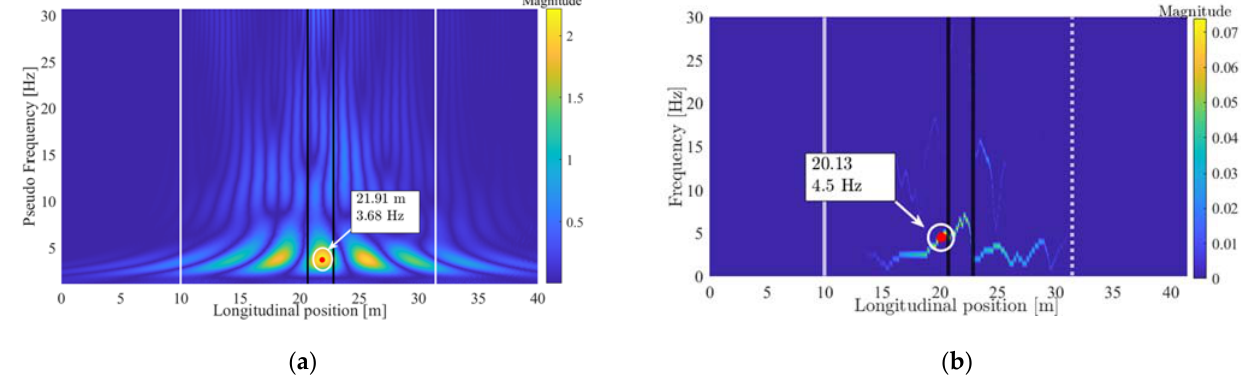
Figure 9. Leading bogie front right accelerations in the case of the healthy and the damaged bridge, respectively, and the time-invariant irregularity profile. Results are for the CSA train travelling at 100 km/h.